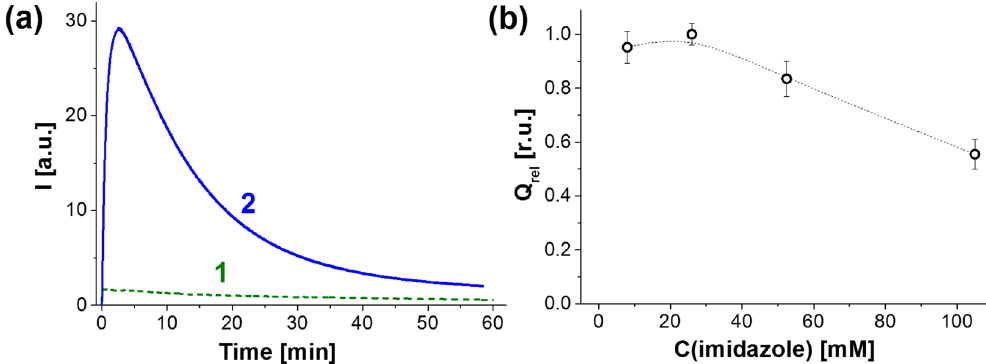
Figure 3. Influence of imidazole on PO-CL reaction. ( a ) The kinetics of light emission in the absence of imidazole (1) and in the presence of 26 mM imidazole (2). ( b ) Dependence of the relative integral intensity of chemiluminescence of the dispersions on the concentration of added imidazole. C(L64) = 1.0 mg/mL, C(DMP) = 2.66 mg/mL, C(POX) = 0.30 mg/mL, C(TMHP) = 7.6 μ M, C(H 2 O 2 ) = 15.0 mM. The integral intensities were normalized to the value obtained at 26 mM of imidazole (Q rel = Q/Q max